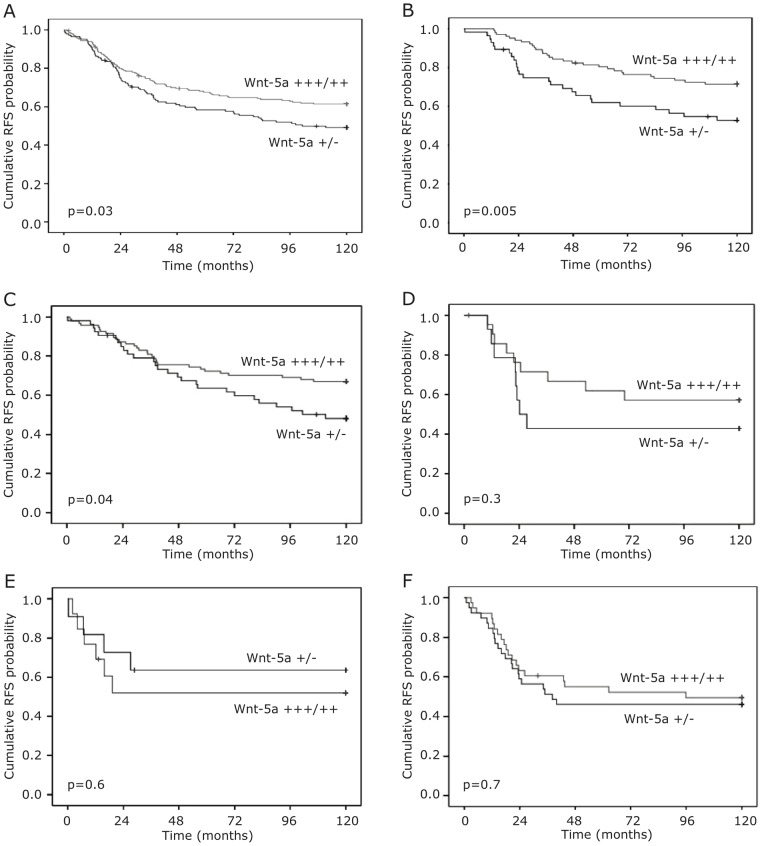
Recurrence-free survival according to Wnt-5a expression.Kaplan–Meier estimates of recurrence free survival according to Wnt-5a status in A. whole cohort, B. ER+ patients. C–F. Kaplan–Meier estimates of recurrence-free survival according to Wnt-5a status stratified for breast cancer subtype. C. Luminal A, D. Luminal B, E. HER2+, and F. TNBC.